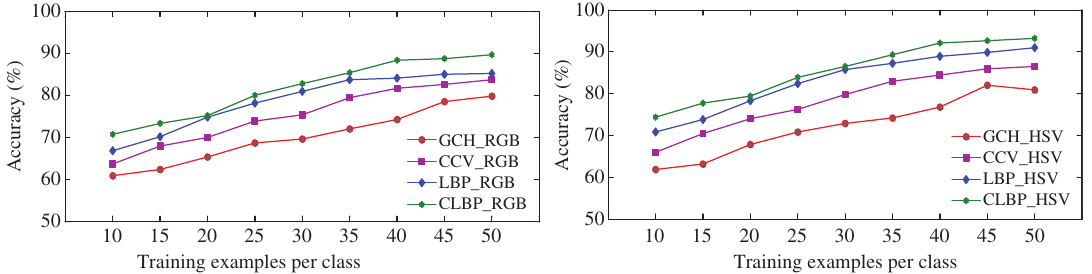
Figure 7. Apple Fruit Disease Average Classification Accuracy using GCH, CCV, LBP, and CLBP Features Considering MSVM as a Base Learner in the RGB and HSV Color Spaces [19].